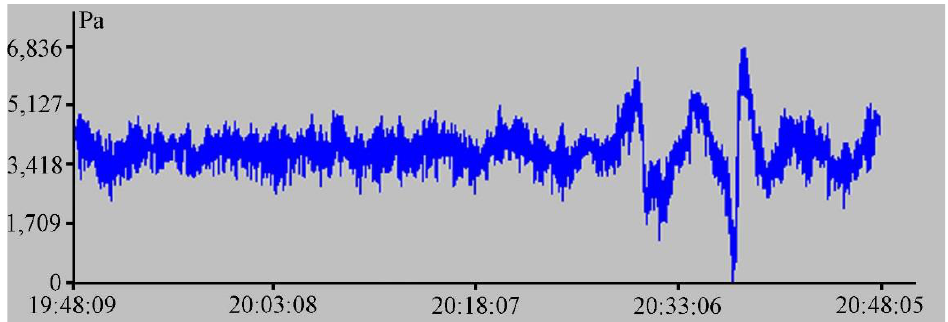
Figure 14. A recording section of the supersensitive detector of hydrosphere pressure variations for 2 June 2021 installed on the seabed at a depth of 27 m at Cape Shultz.